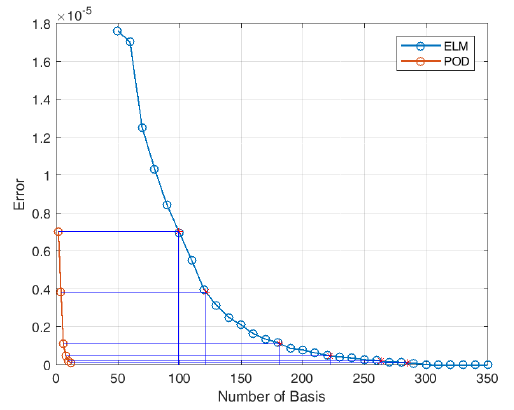
Figure 6. Error ( err POD , err ELM ) using different number of basis ( K ) for both POD reconstruction and K K ELM